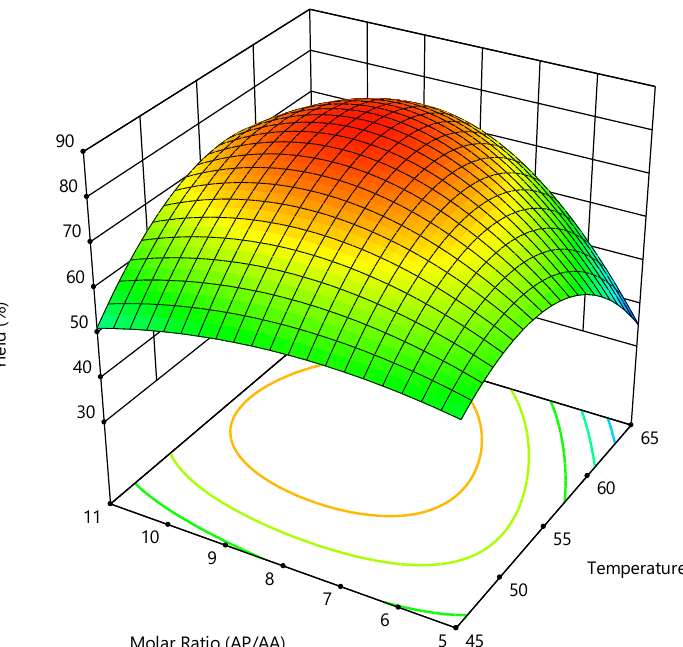
Figure 3. Response surface for the effect of temperature and ascorbic acid: palmitic acid molar ratio on the synthesis yield of ascorbyl palmitate. The synthesis reaction was performed in pure 2M2B at 150 rpm with 12 g/L of Novozym 435.